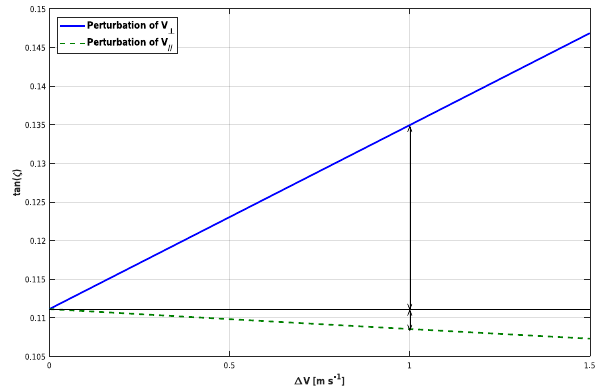
Figure 10. Variation in the inflow angle ζ at a blade section as a function of a perturbation (cid:49)V in a direction either perpendicular (solid line) or parallel (dashed line) to the rotor